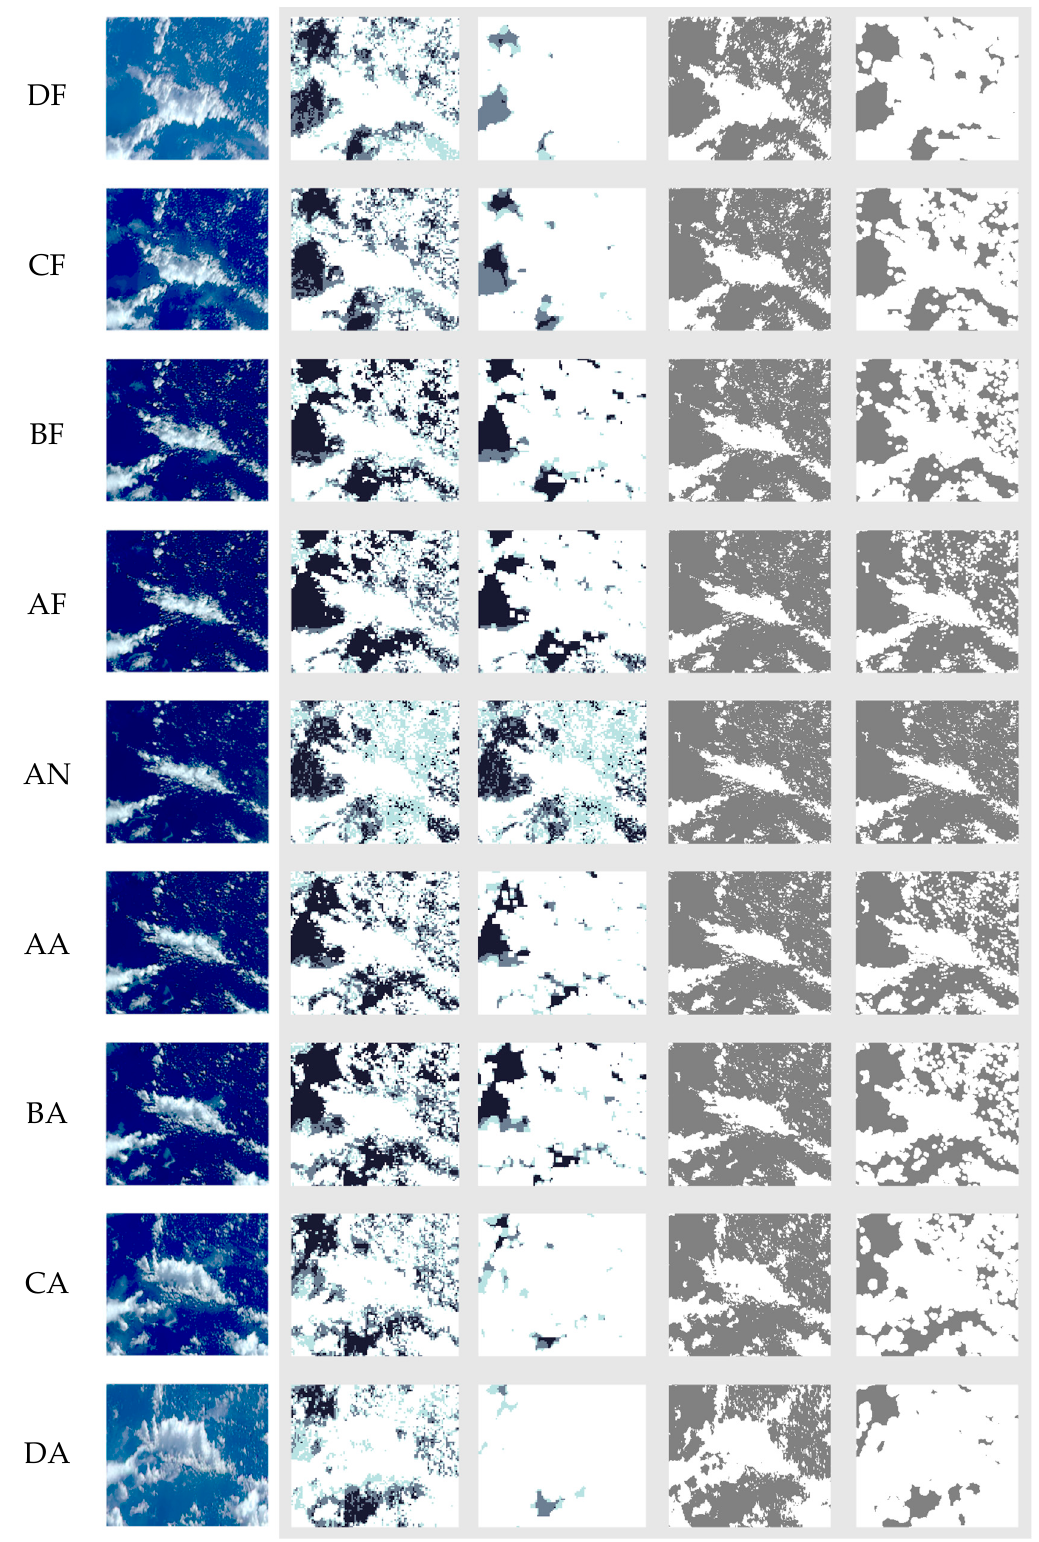
is due to sun glint.